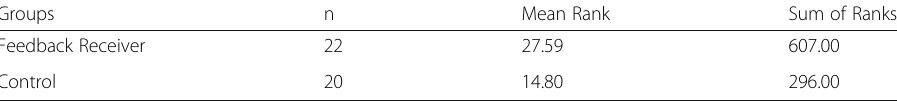
Table 12 Feedback receiver group and control group ranks in the picture description task Groups